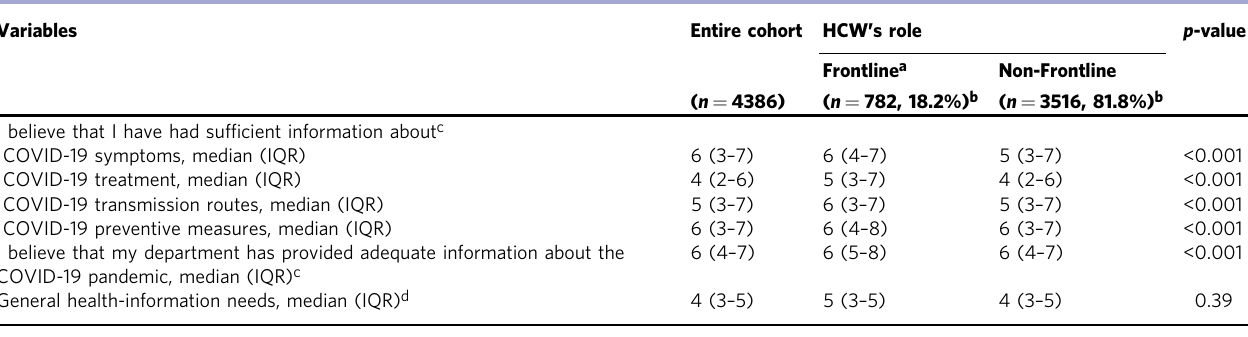
Table 3 Healthcare workers ’ perceptions regarding the suf fi ciency of information about COVID-19 and general health information needs.